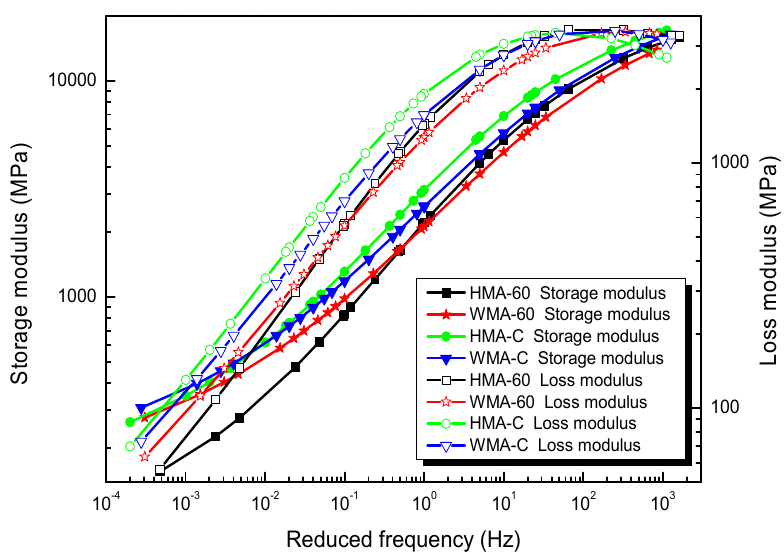
Figure 3. Master curve of storage modulus and loss modulus.